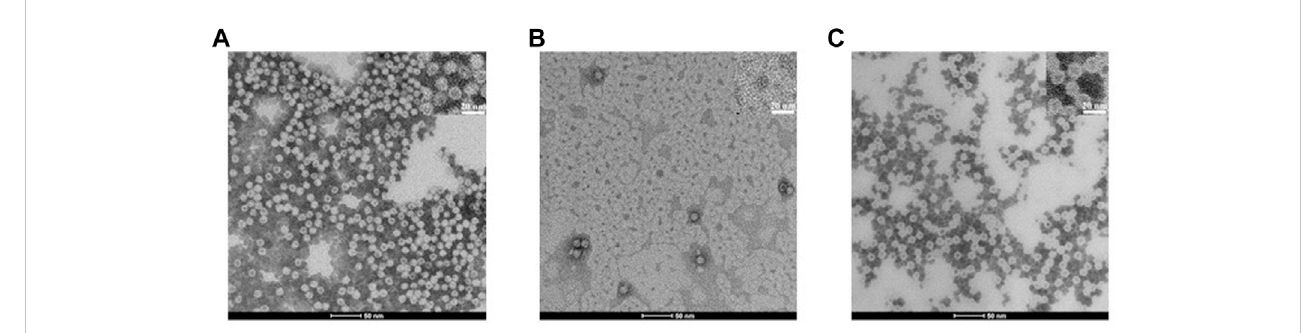
FIGURE 3 TEM bright fi eld images ((scale bar = 50 nm, upper inset, 20 nm) of hHFt during the SDS treatment. (A) Reference (untreated) hHFt. (B) hHFt SDS 0.1% ; (C) hHFt